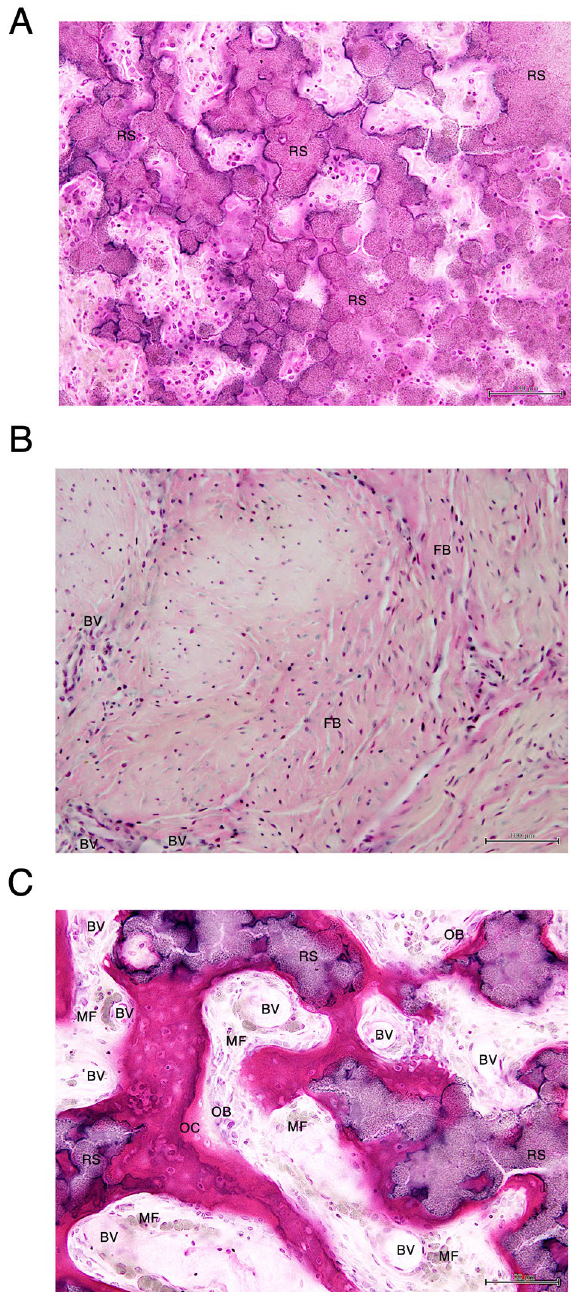
Figure 5. High magnification image of hematoxylin–eosin staining. The same specimens from Fig. 4 were investigated using hematoxylin–eosin staining at high magnification. ( A ) In the control specimen, the vast majority of the area was filled with remnant scaffold (RS). ( B ) The rhBMP-2 specimen shows abundant fibroblasts (FBs) with a small number of blood vessels (BV). ( C ) In the HMGB-1 specimen , RS is enclosed by a calcified bone structure. Active vascularization was confirmed by BVs. Macrophages (MF) phagocytizing β-TCP particles (grayish-green color) were observed along with the blood vessels. Numerous osteoblasts (OB) were identified on the osteoid surface, and osteocytes (OC) were encapsulated in the osteoid bone matrix. Magnification 20 ×. Scale bar = 100